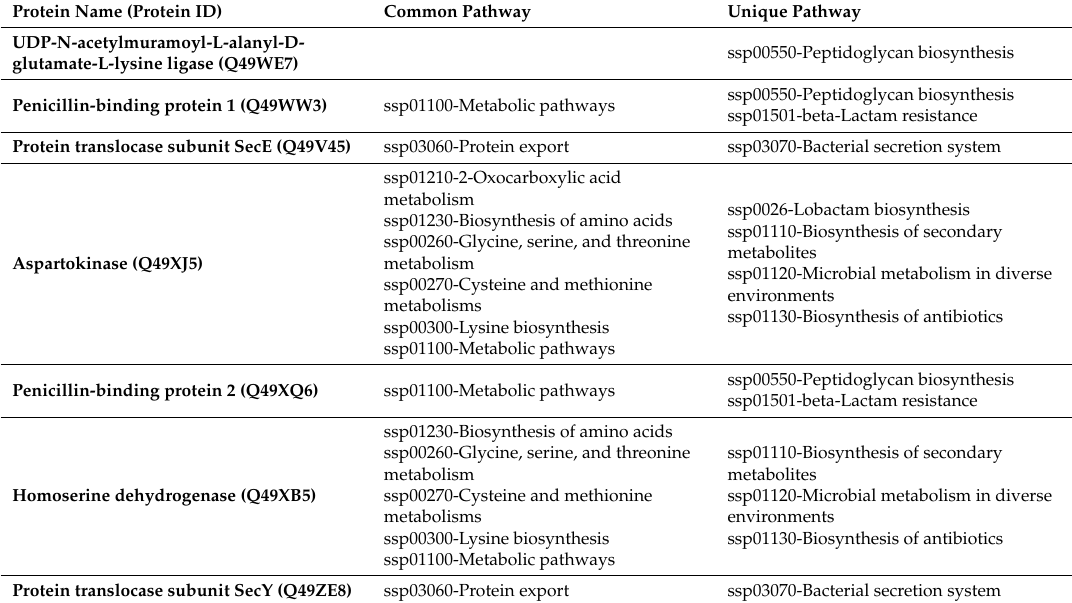
Table 1. Essential non-homologous proteins involved in 17 unique metabolic pathways (UMPs).